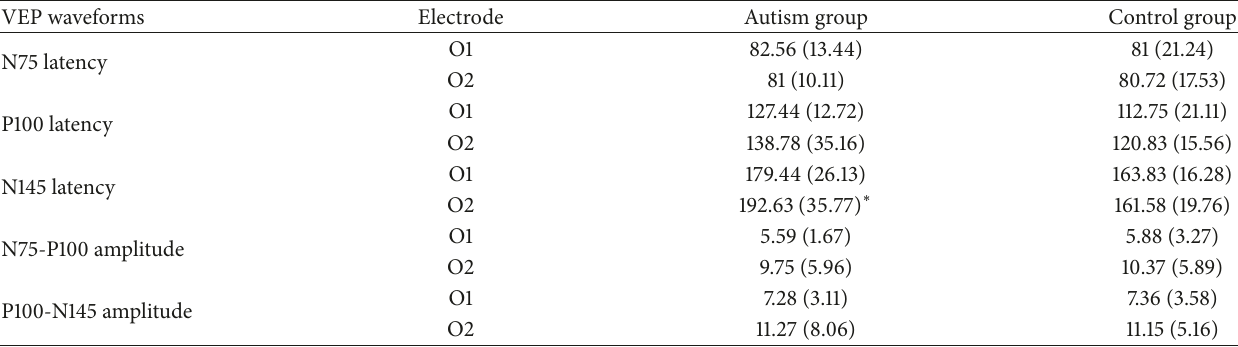
Table 3: A comparison between the VEP waveforms generated in each hemisphere, at the O1 electrode site for left occipital and the O2 electrode site for right occipital areas.